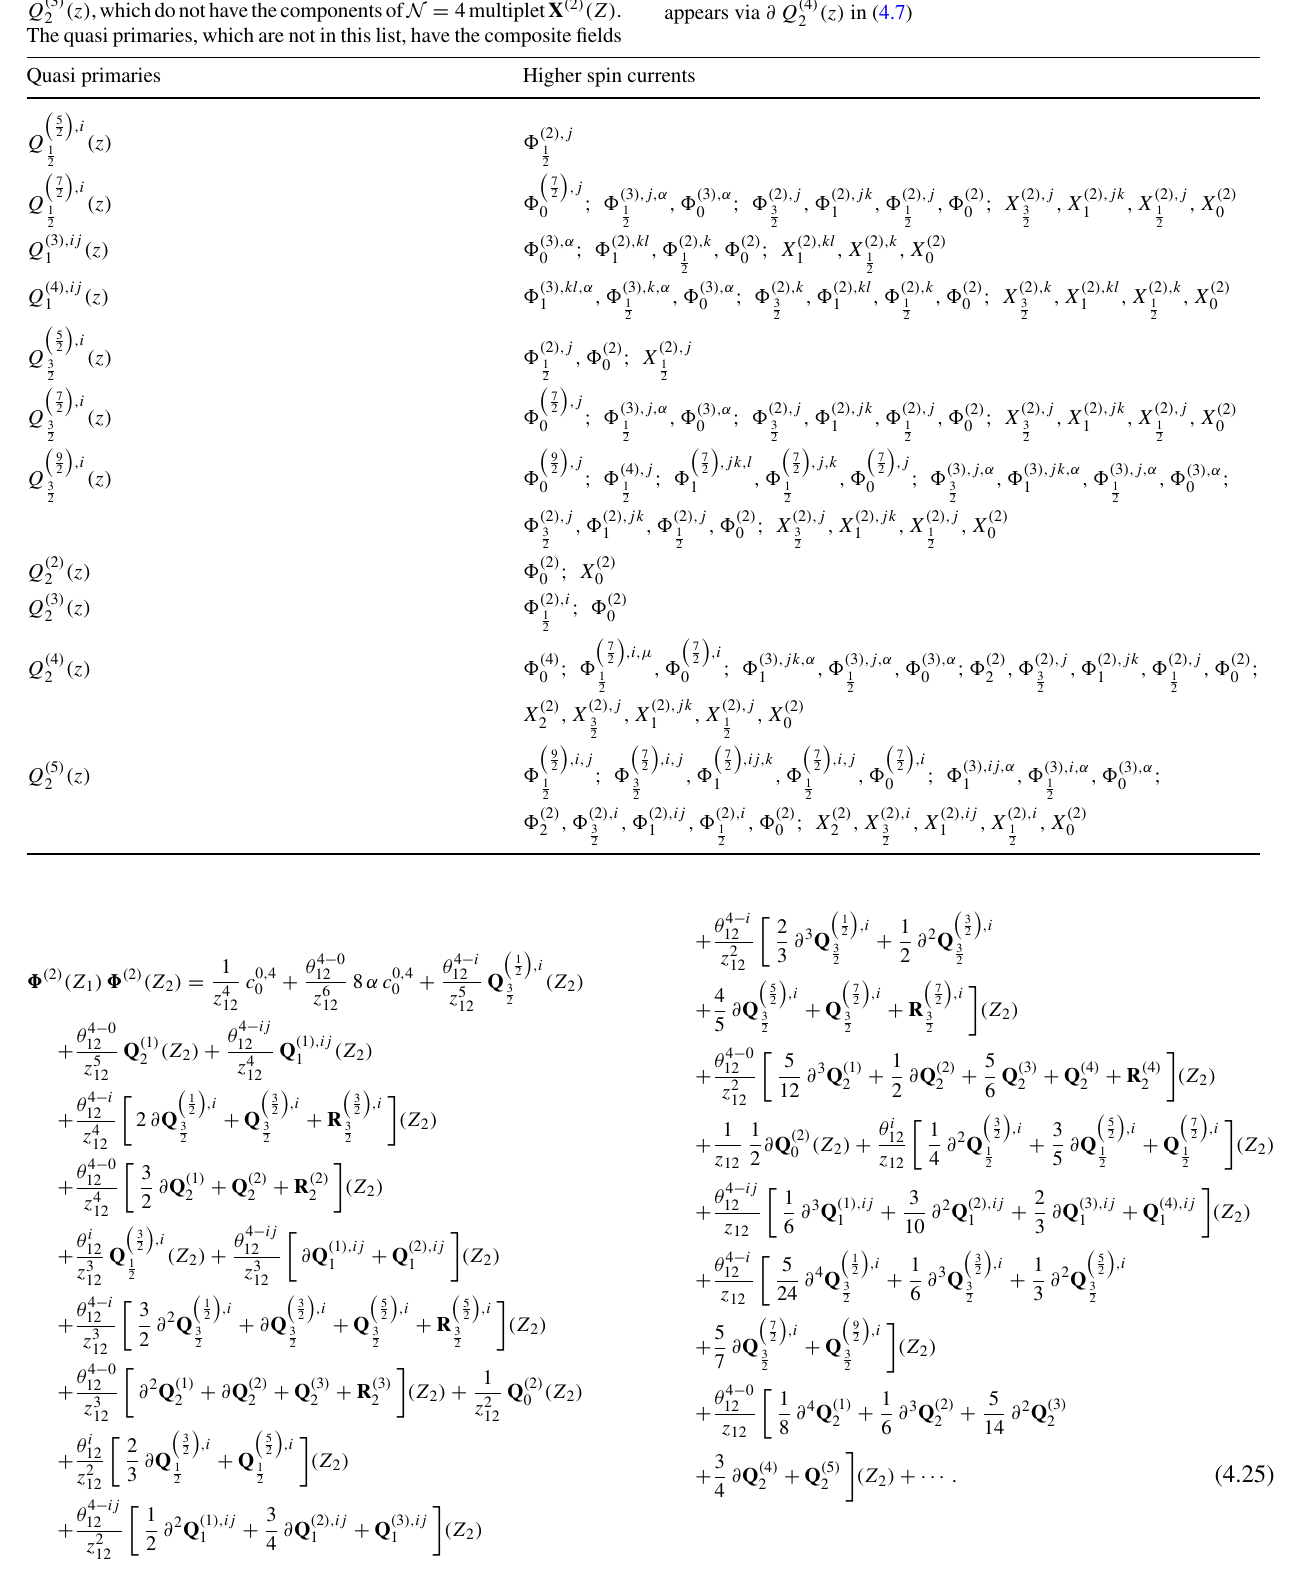
Table 1 The structure constant w 1 , 2 ≡ C ( 2 ) ( above quasi primaries appearing in the OPEs except